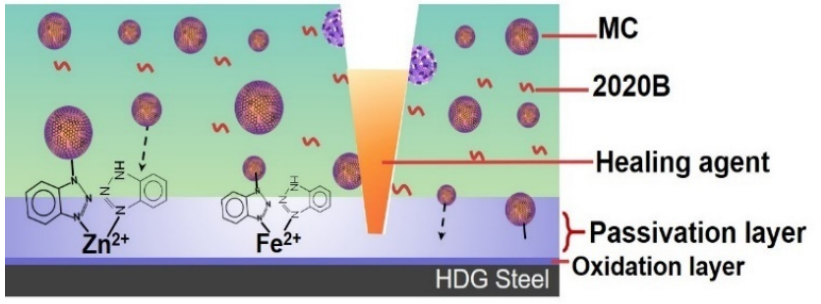
Figure 7. The effects of the dual functional GO microcapsules. Table 3. The electrochemical parameters for different coatings.